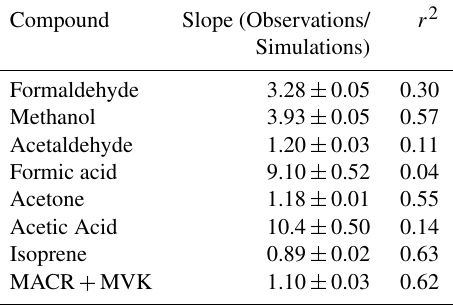
Table 2. Comparisons and correlations of main observed VOCs hourly mixing ratios to hourly mixing ratios simulated by GEOS- Chem + MEGANv2.1, based on major axis